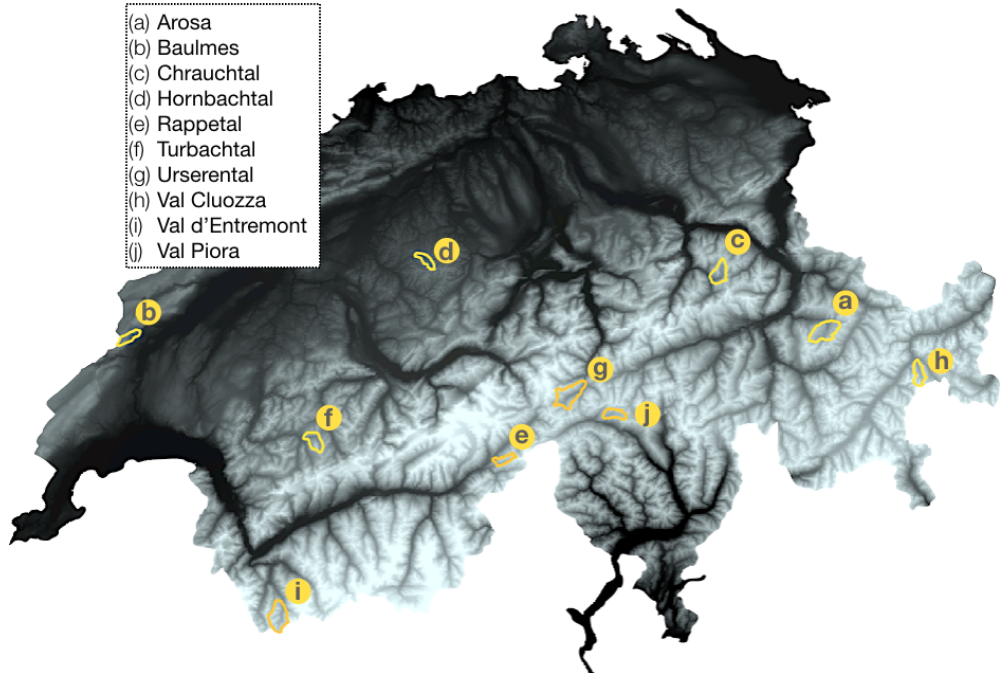
Figure 2. Map of Switzerland showing the 10 selected study sites (outlined in yellow). Colours of the map show lower elevations in dark and higher elevations in lighter colours. Digital terrain model obtained from ©